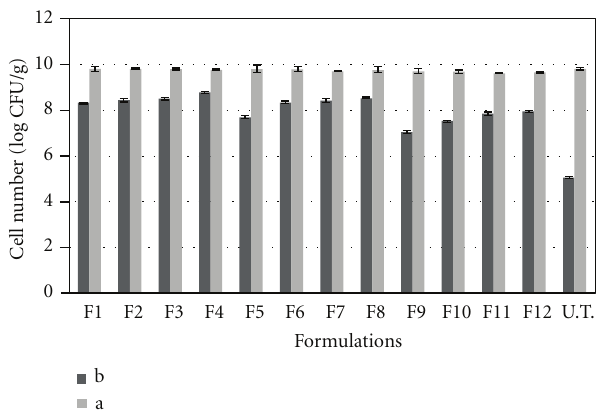
Figure 3: The viability of L. acidophilus (CFU/g) encapsulated in di ff erent ALG or ALG-PSL formulations (F1–F12) and untreated cells. (a) The counts after 2h acid exposure, (b) The counts after 2 h acid exposure followed by 2 h bile